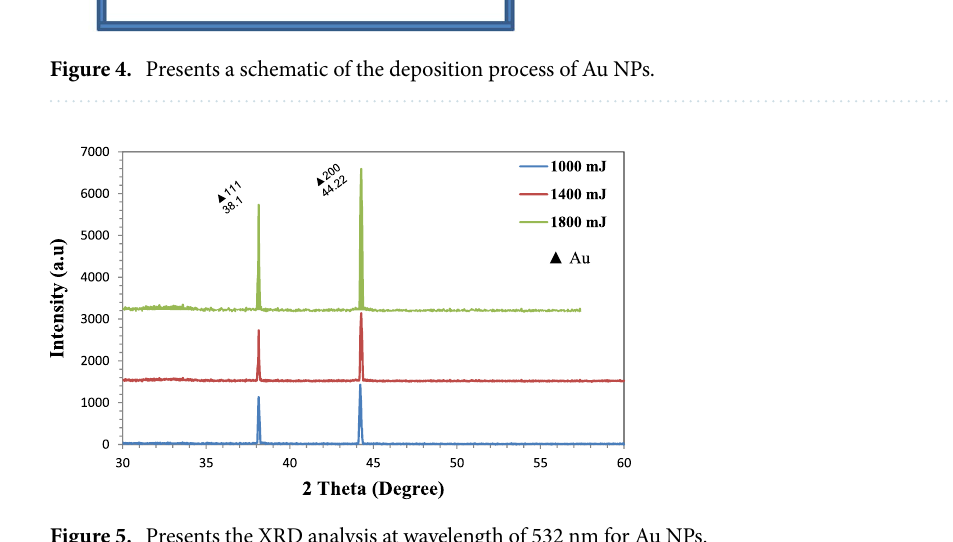
Figure 5. Presents the XRD analysis at wavelength of 532 nm for Au